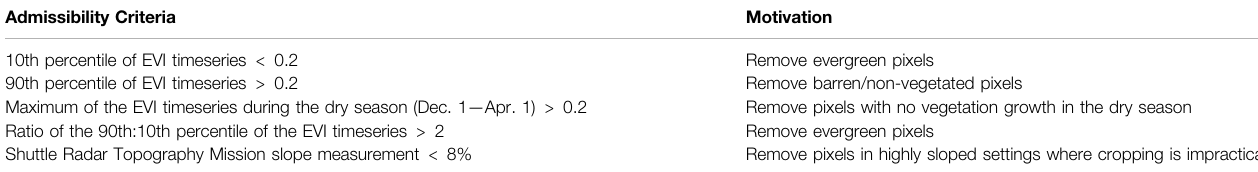
TABLE 1 | Prediction admissibility criteria. All criteria need to be satis fi ed for a prediction to be admitted as irrigated. Admissibility Criteria